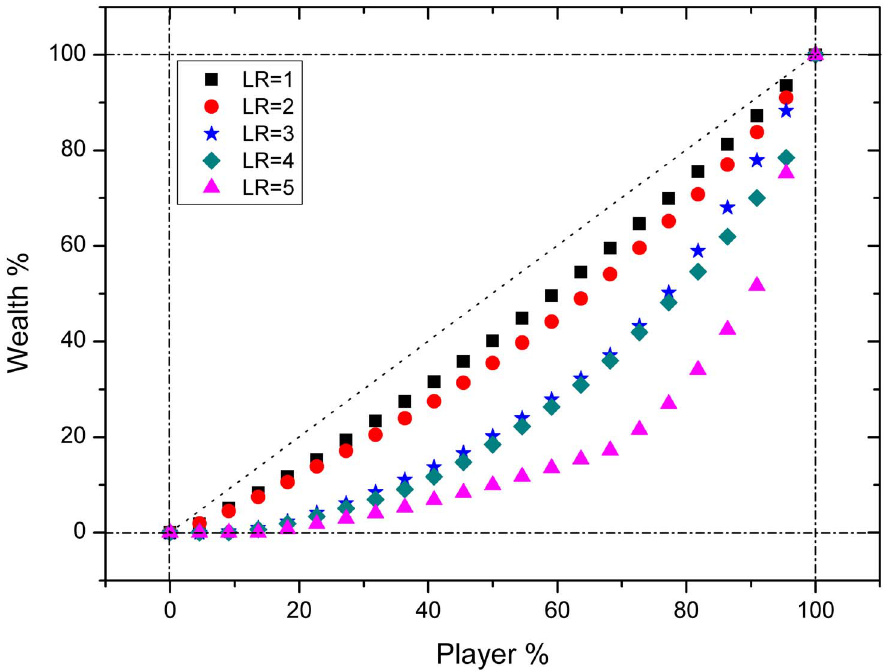
Figure 4. The Gini coefficient trend of the experiments with changing LR . Each dot represents the percentage of total wealth (Y Axis) that a certain percentage of total players (X Axis) have. As the LR goes up, Gini coefficient (the ratio of area between the Lorenz Line and the 45 degree straight line to the whole triangle area) goes up as well, which indicates that the wealth distribution becomes more uneven.